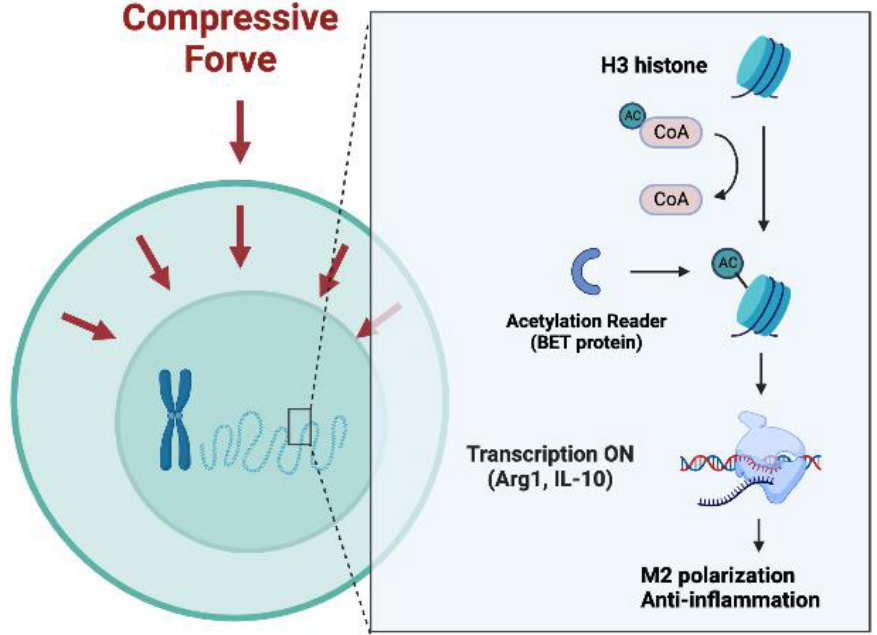
Figure 6. Compressive force enhances H3 histone acetylation to promote M2 polarization.